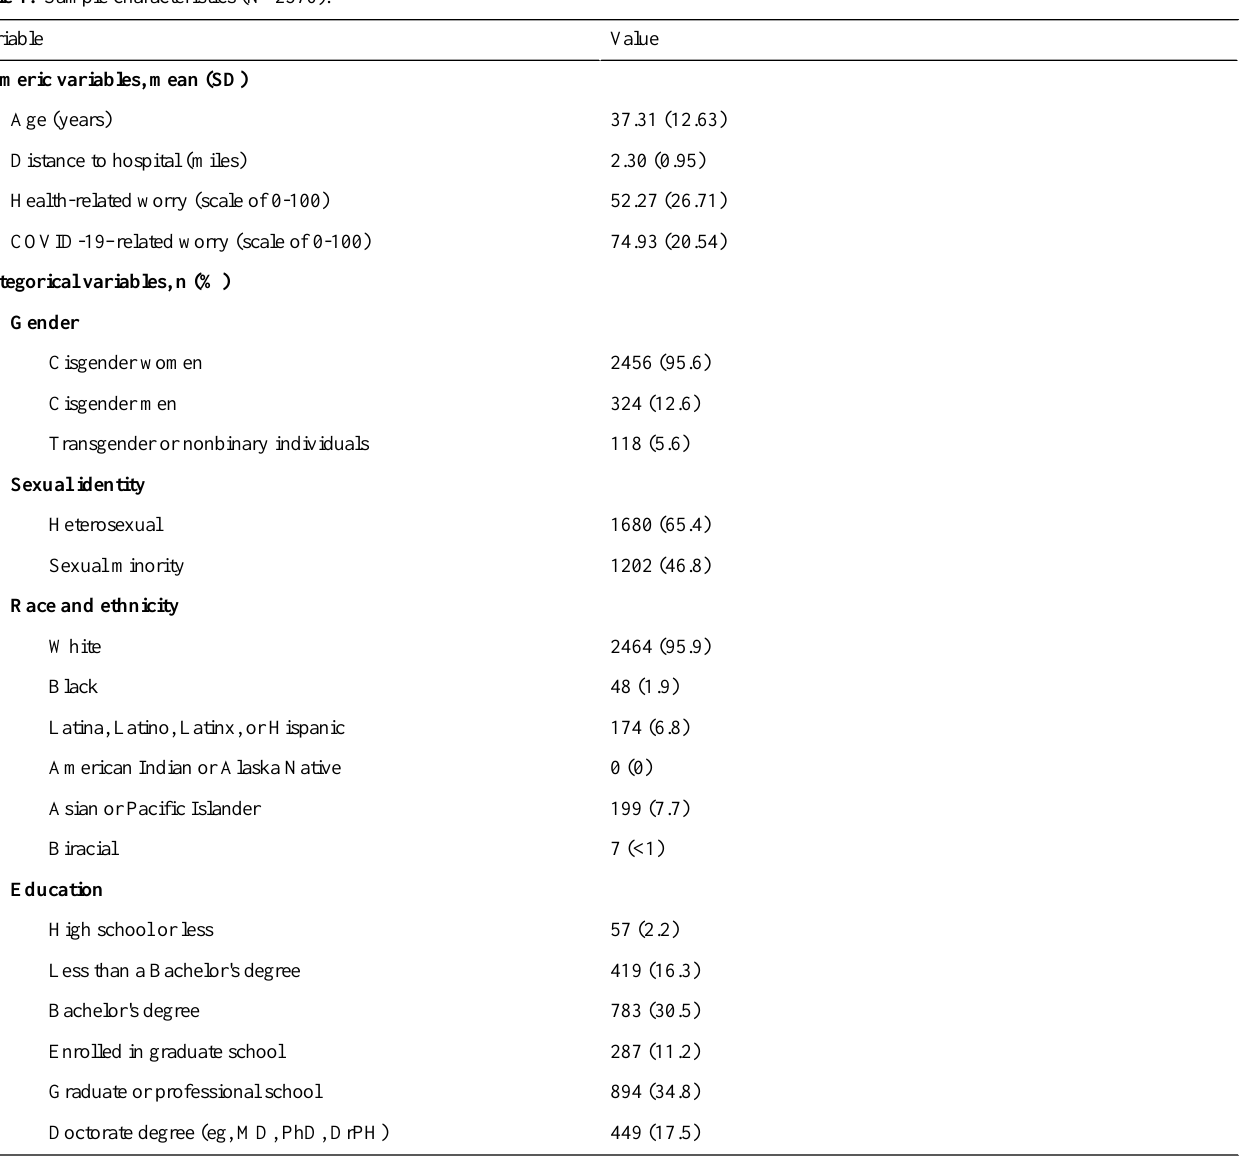
Table 1. Sample characteristics